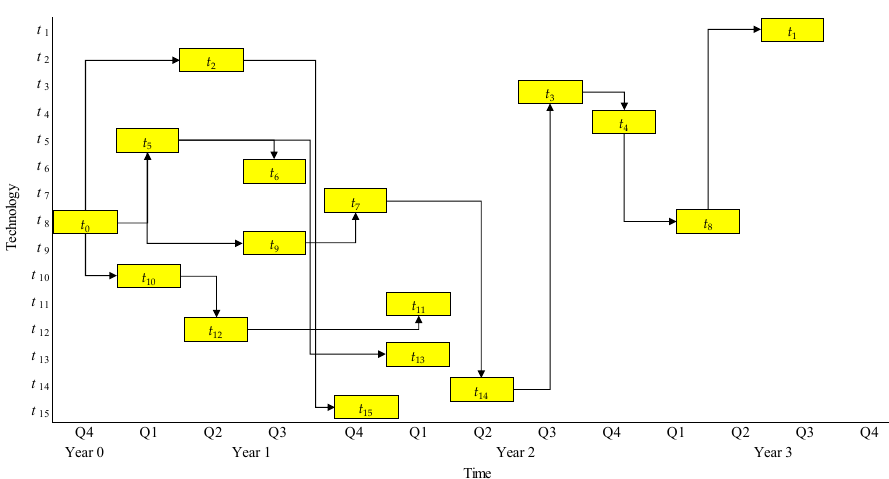
Figure 5. The roadmap of each expanding